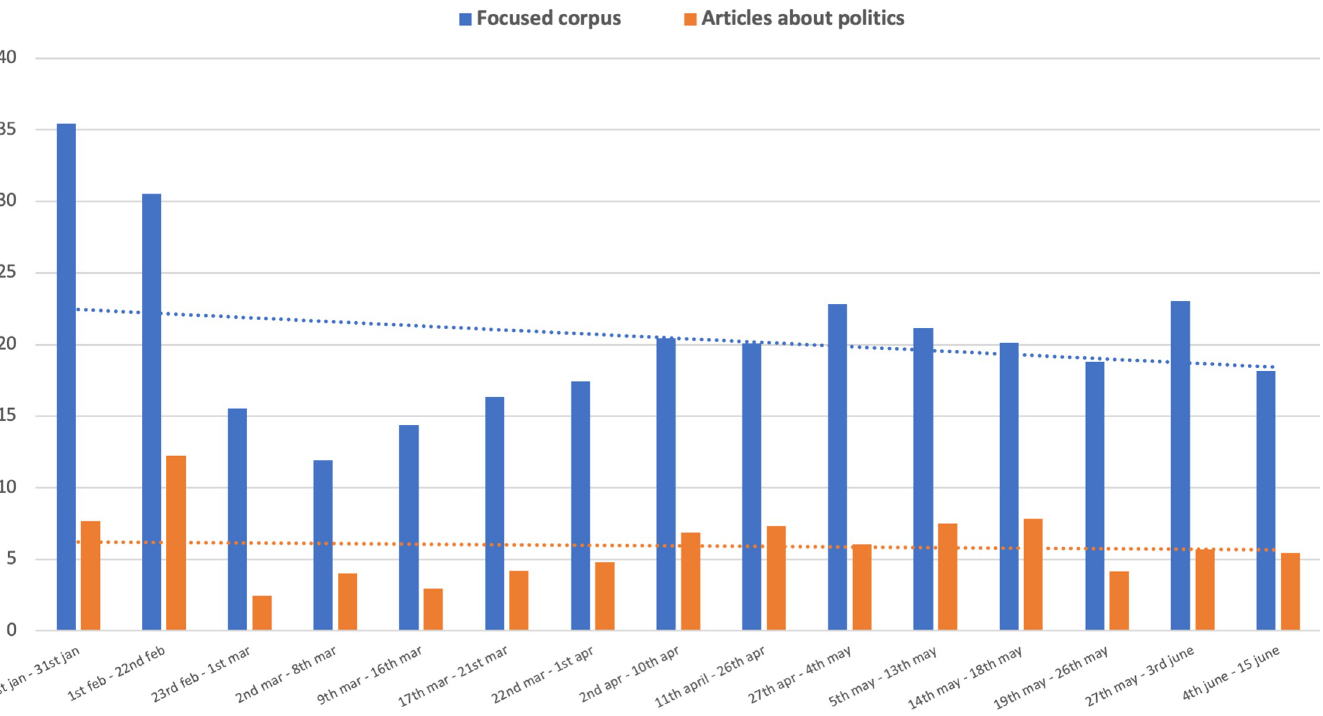
Fig 5. Trend comparison over time about scientific salience in the “SARS-CoV-2 focused corpus” ( μ = 20.41) and in articles with political content ( μ = 5.94).